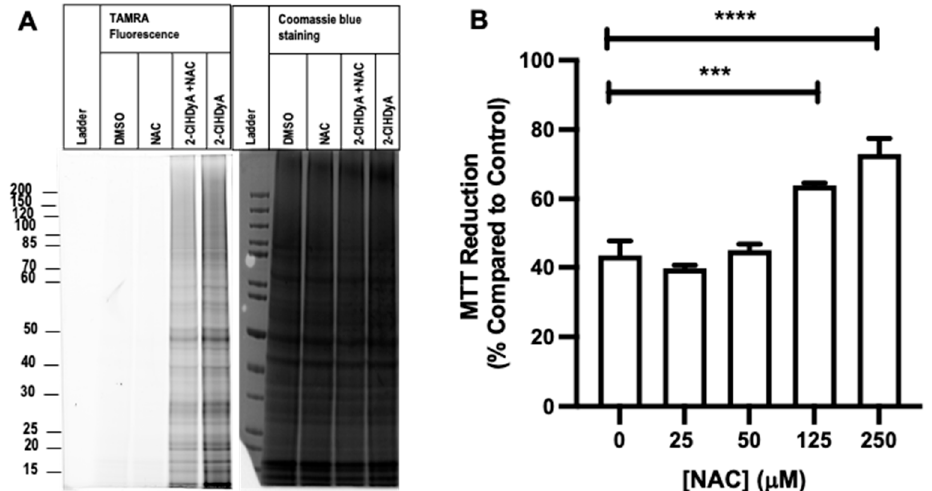
Figure 5. NAC prevents protein modification and toxicity elicited by 2-ClFALD. ( A ) RAW 264.7 cells were pretreated with 250 µM NAC for 30 min at 37 °C followed by treatment with 25 µM 2-ClHDyA for 1 h at 37 °C. Following click reactions with TAMRA-azide, protein fluorescence (TAMRA) and protein (Coomassie blue) were detected. ( B ) RAW 264.7 cells were pretreated with selected concentrations of NAC for 30 min at 37 °C followed by treatment with 25 µM 2-ClHDA for 5 h. MTT assay was performed as described in “Materials and Methods”. n = 4 for each treatment from independent experiments. *** p < 0.001, **** p < 0.0001 for comparison of MTT reduction caused in the presence of NAC preincubation in comparison to the treatment condition without NAC incubation determined by ANOVA with Dunnett’s post-hoc test.